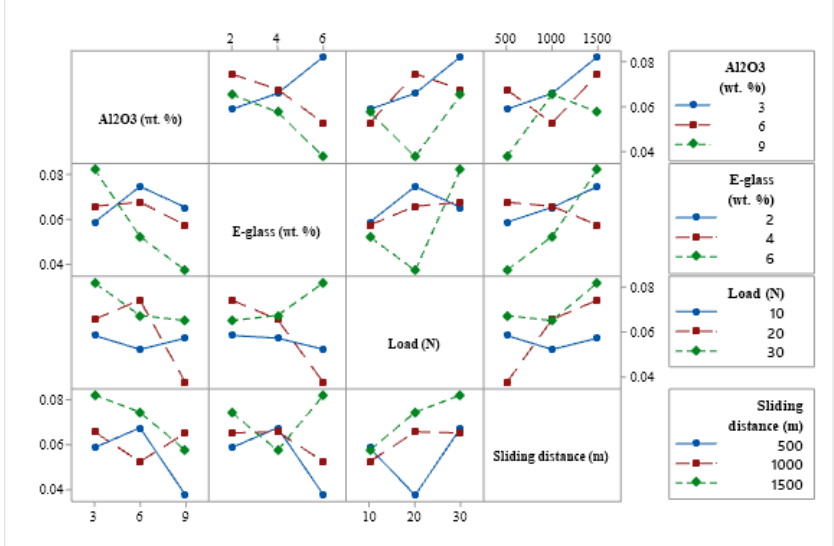
Fig. 5. Interaction plot wear rate of the composite.